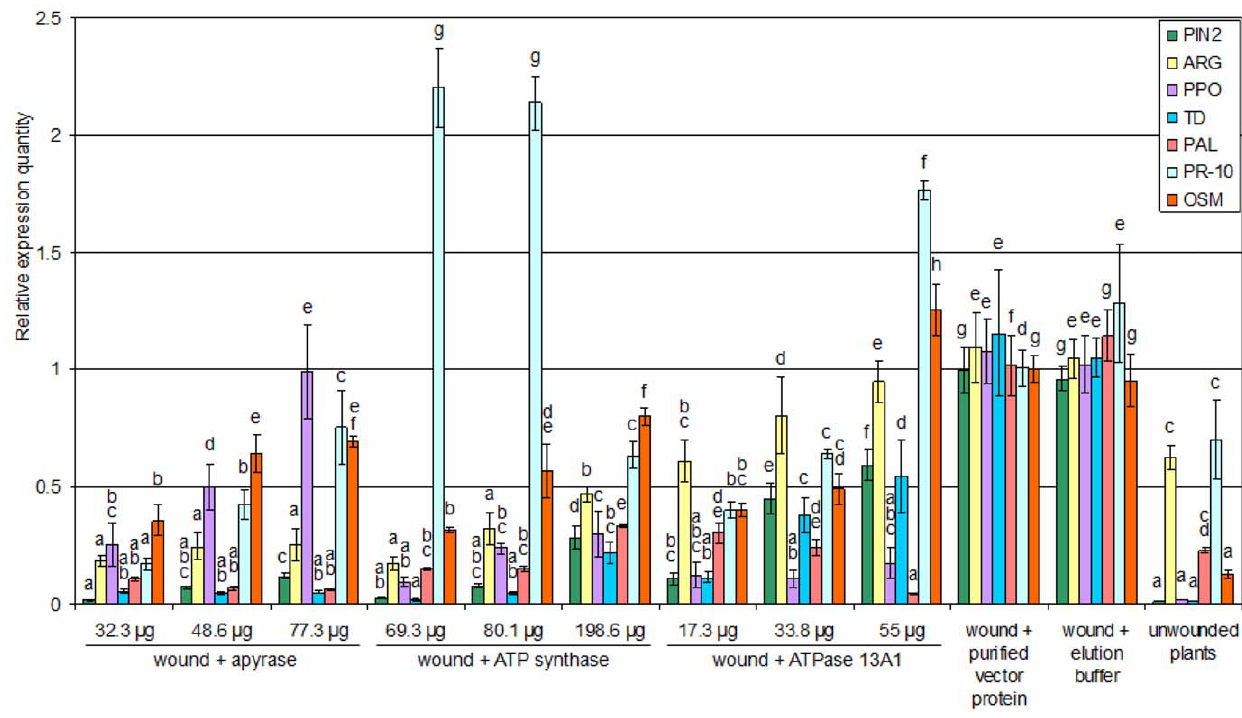
Figure 4. The relative expression levels of defense genes among tomato leaves after different treatments. Total RNAs were extracted from tomato leaves after 24 h of different treatments. Different quantities of proteins with the same total ATP hydrolysis activity of 74.3 pmol ? L 2 1 ? min 2 1 were indicated. Ubiquitin was used as the internal reference. The expression level of each gene was normalized to the level in treatment with purified pET-43.1b( + ) vector protein, which contain the impure protein only. Values are expressed as mean 6 SE (n=3). Significance was tested for each gene separately. Different letters above each bar indicate statistical difference determined by ANOVA analysis followed by the Duncan’s Multiple Range Test (P , 0.05).